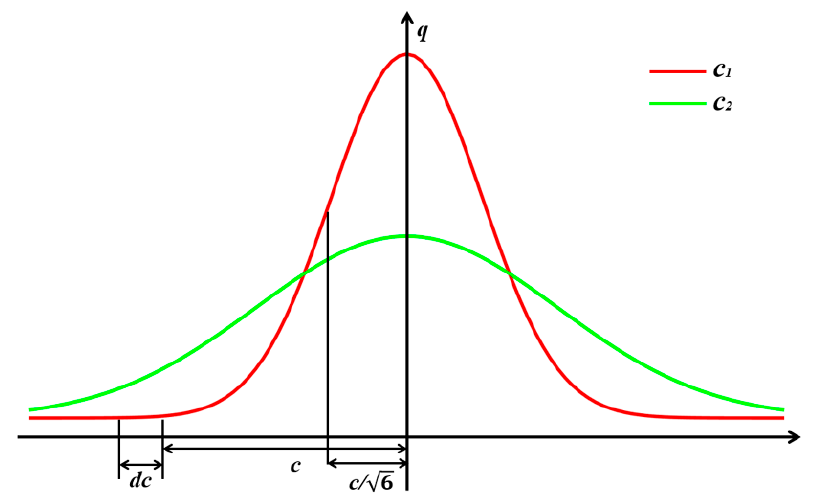
Figure 4. E ff ect of heat source parameter changes on heat flux Figure 4. Effect of heat source parameter changes on heat flux density.